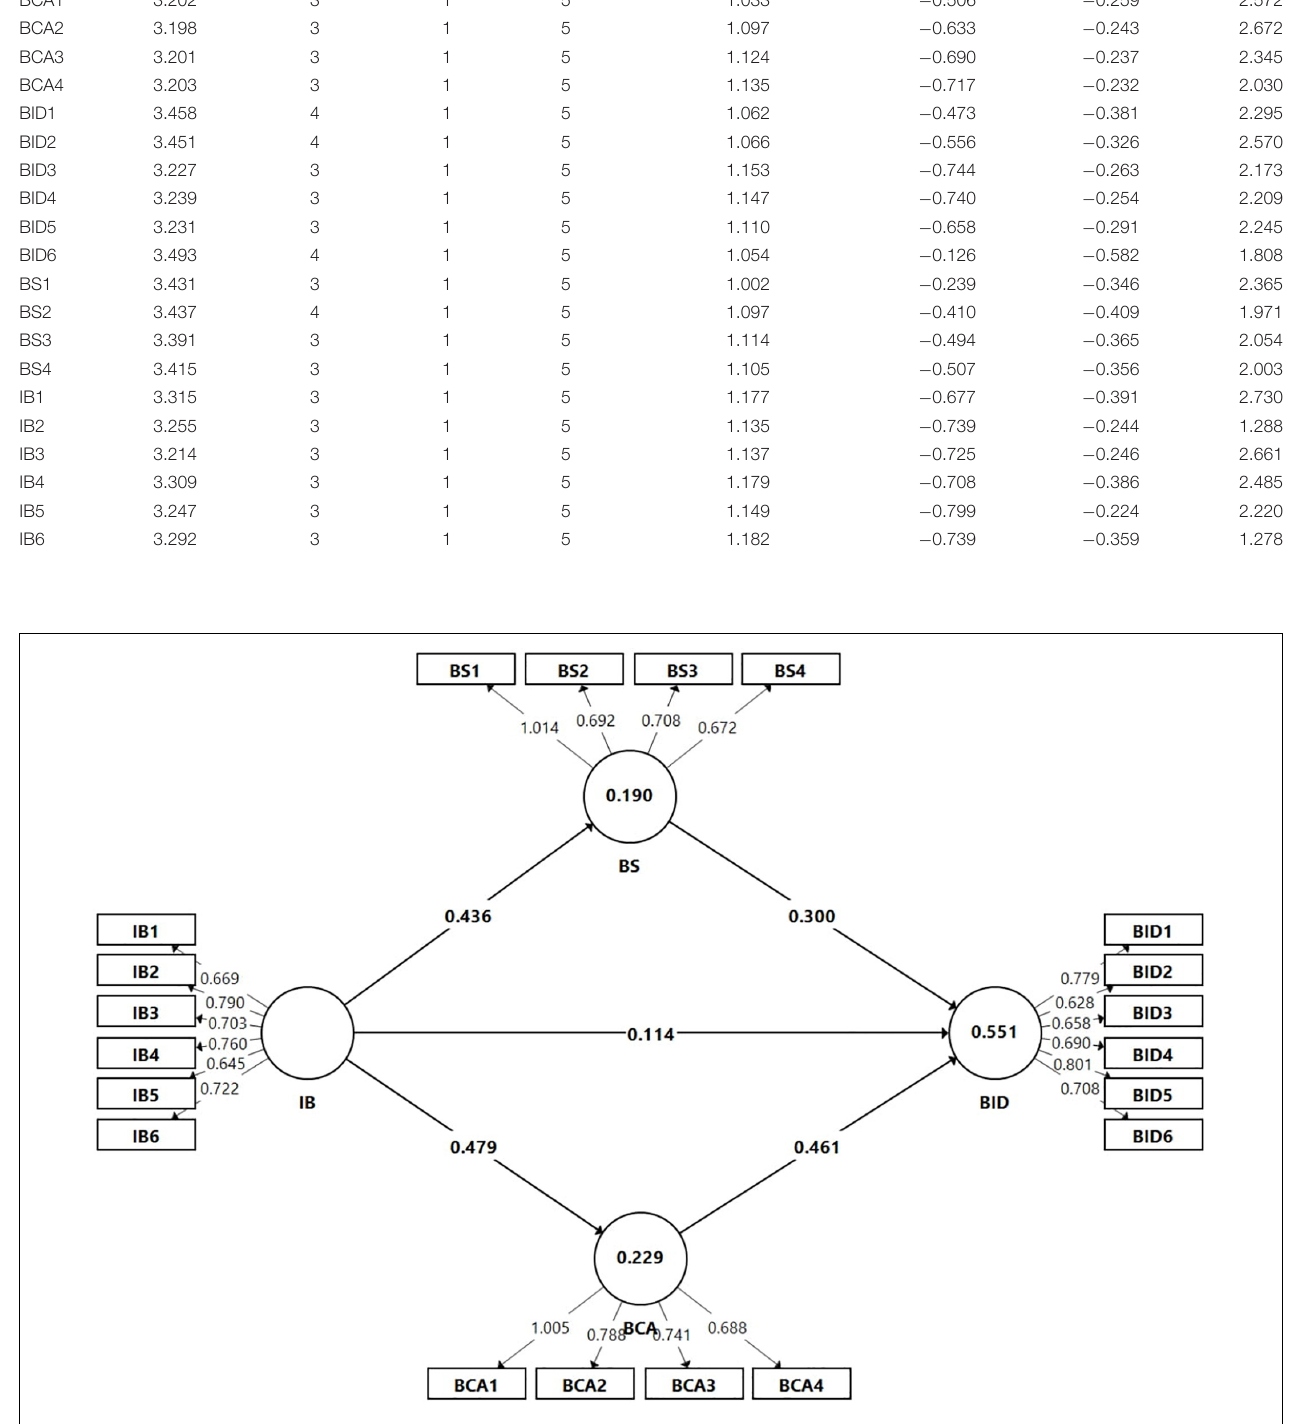
FIGURE 2 | Structural